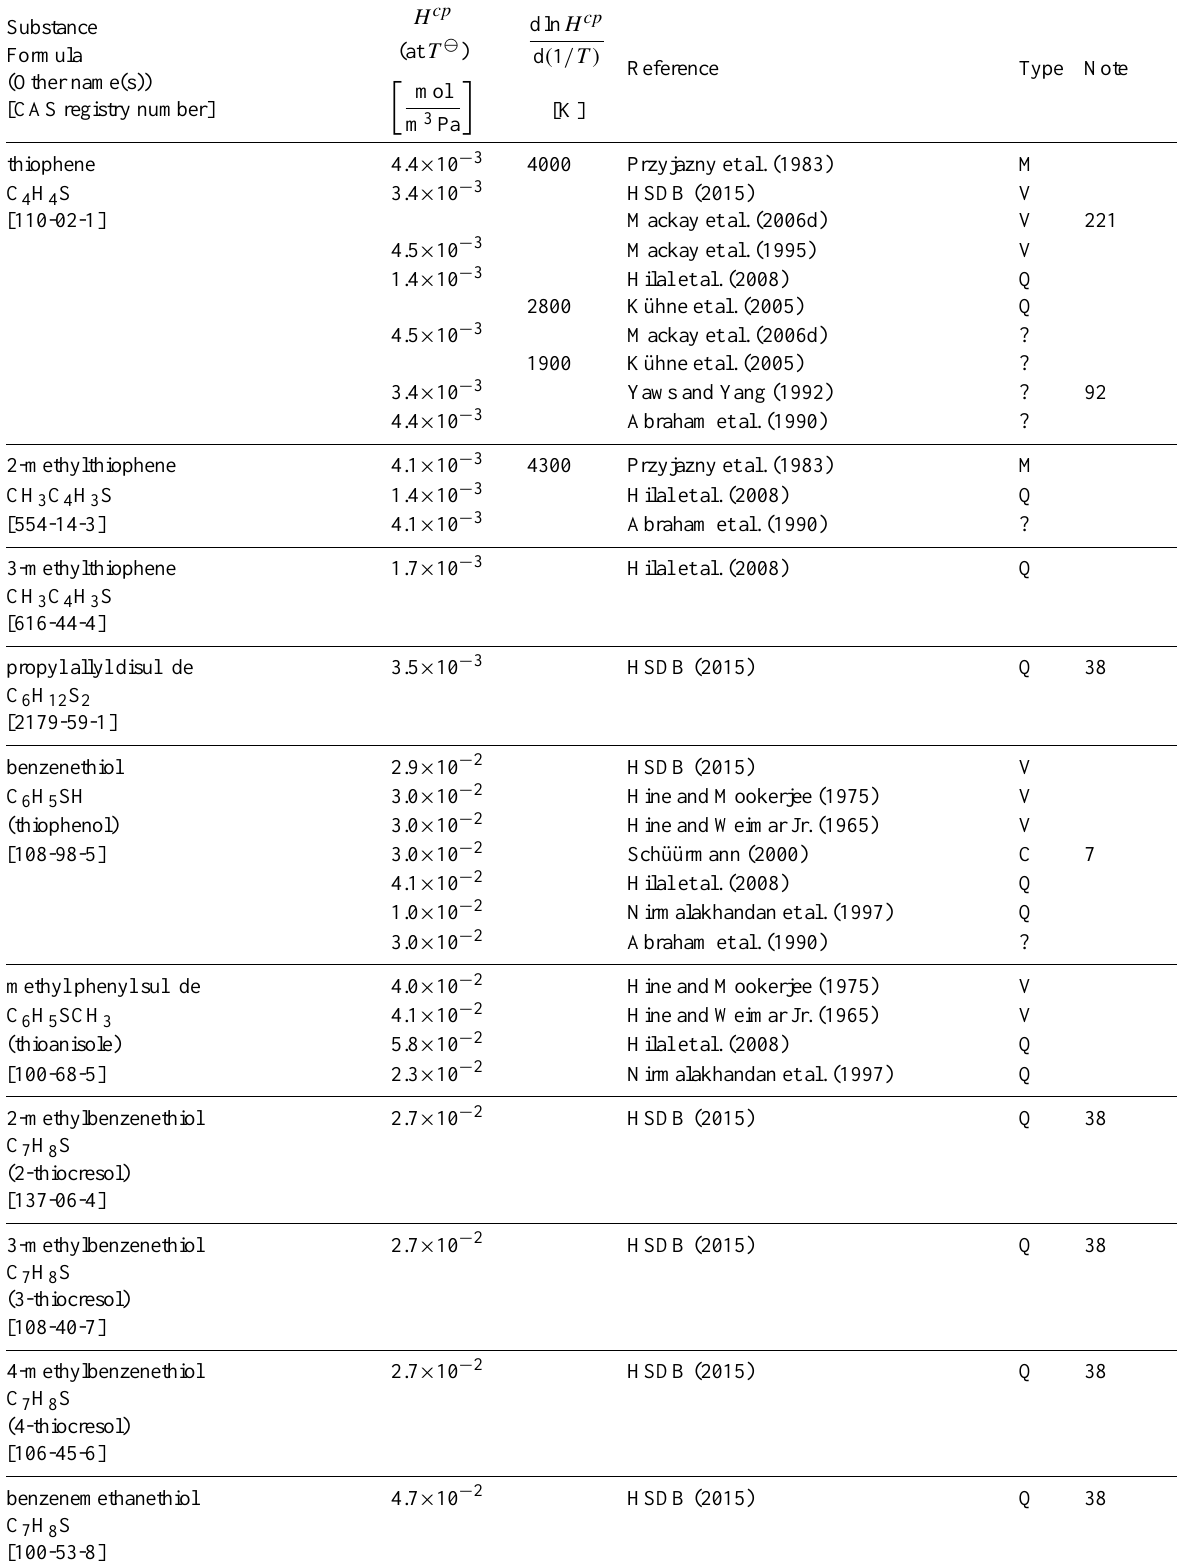
Table 6: Henry’s law constants for water as solvent